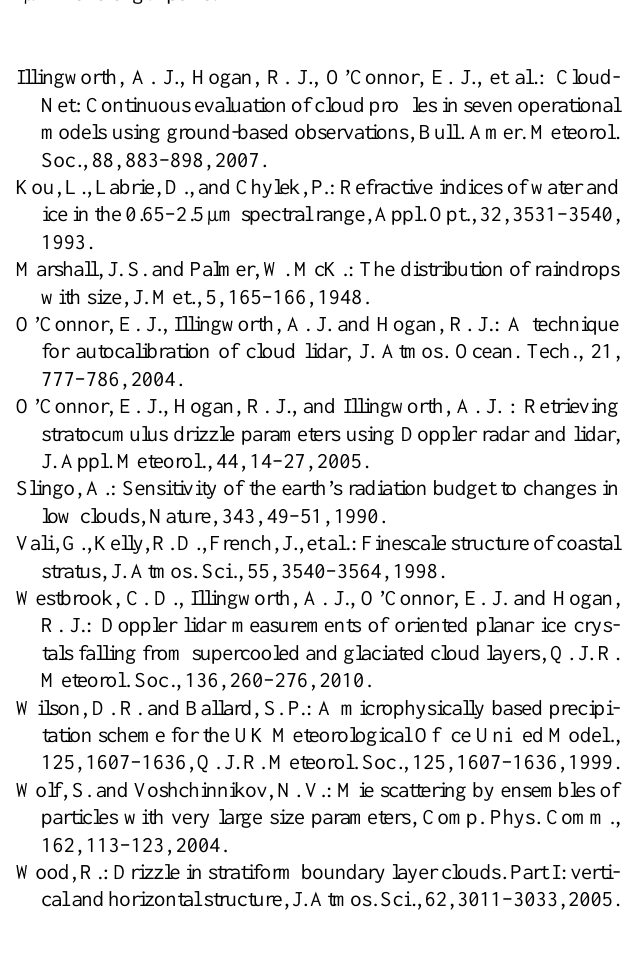
Fig. 14. Colour ratio as a function of D 0 for 1 . 064 – 1 . 5 µ m and 905 nm– 2 µ m wavelength pairs.